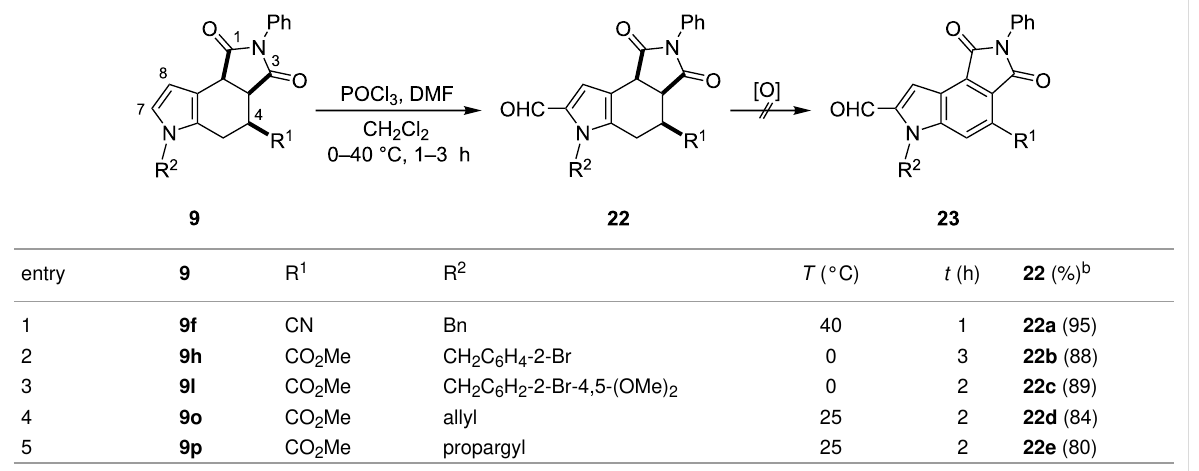
Table 5: Preparation of derivatives 22a – e by formylation of octahydropyrrolo[3,4- e ]indole-1,3-diones 9 . a